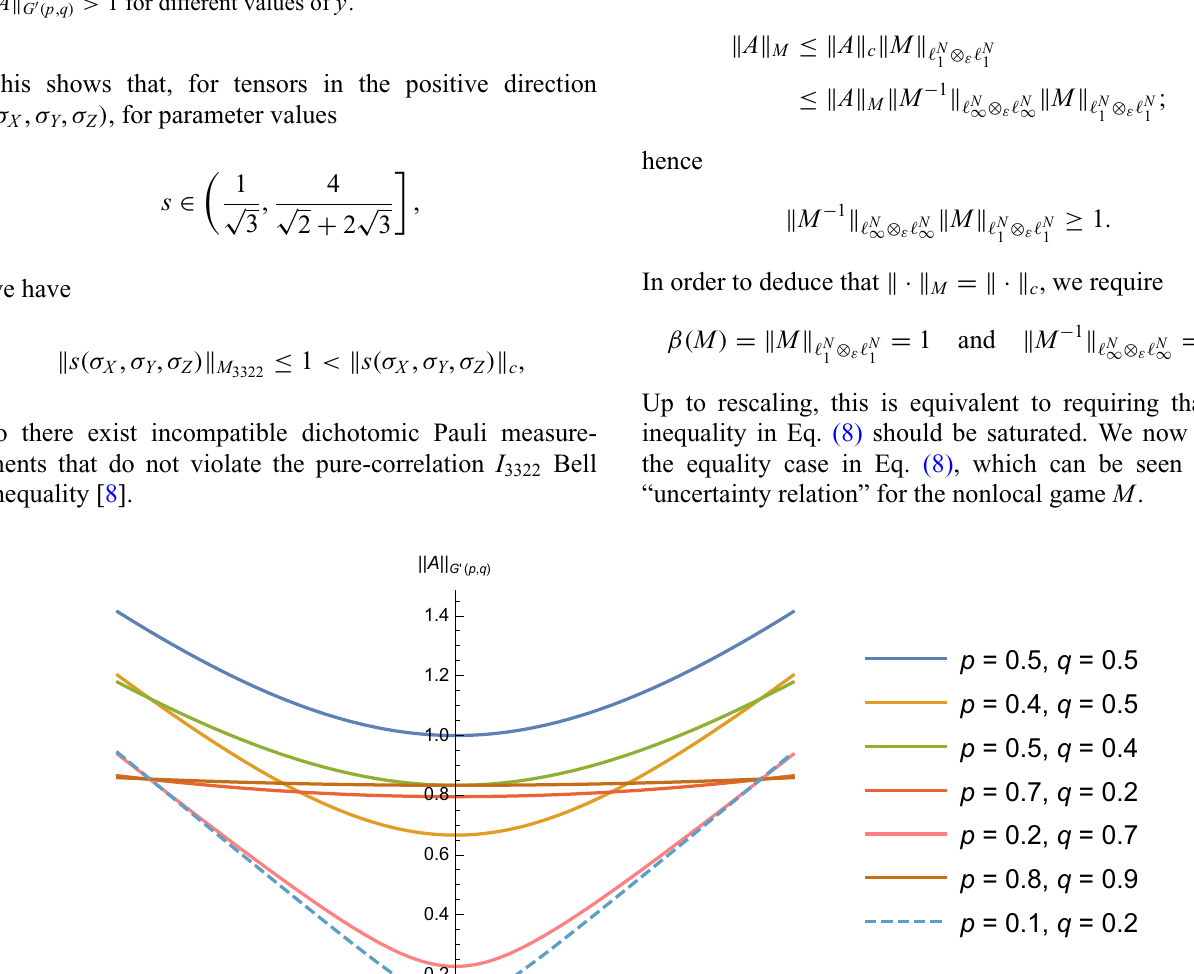
FIG. 8. The norm (cid:2) A (cid:2) G (cid:17) ( p , q ) for y ∈ [ − 1, 1] and different values of p and q